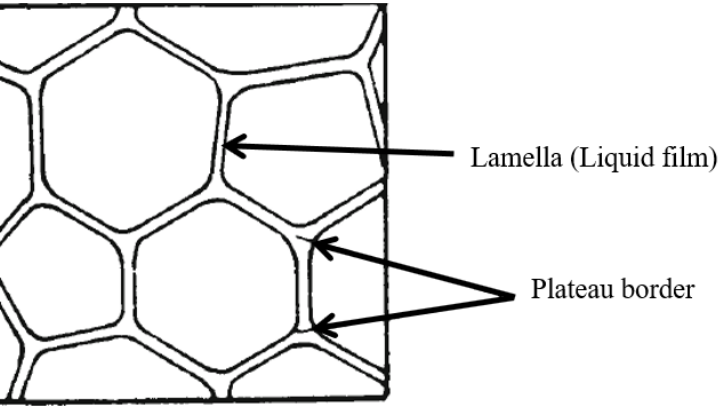
Figure 3. Schematic diagram of a 2D-foam (Adapted with permission from Walstra, [42]). Copyright 1989, Springer-Verlag Berlin Heidelberg